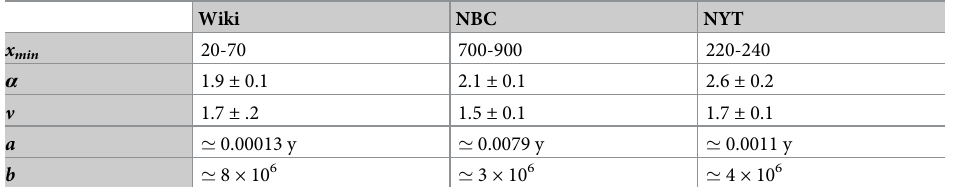
Table 2. Results of fitting Eqs 4 and 6 to WE data.